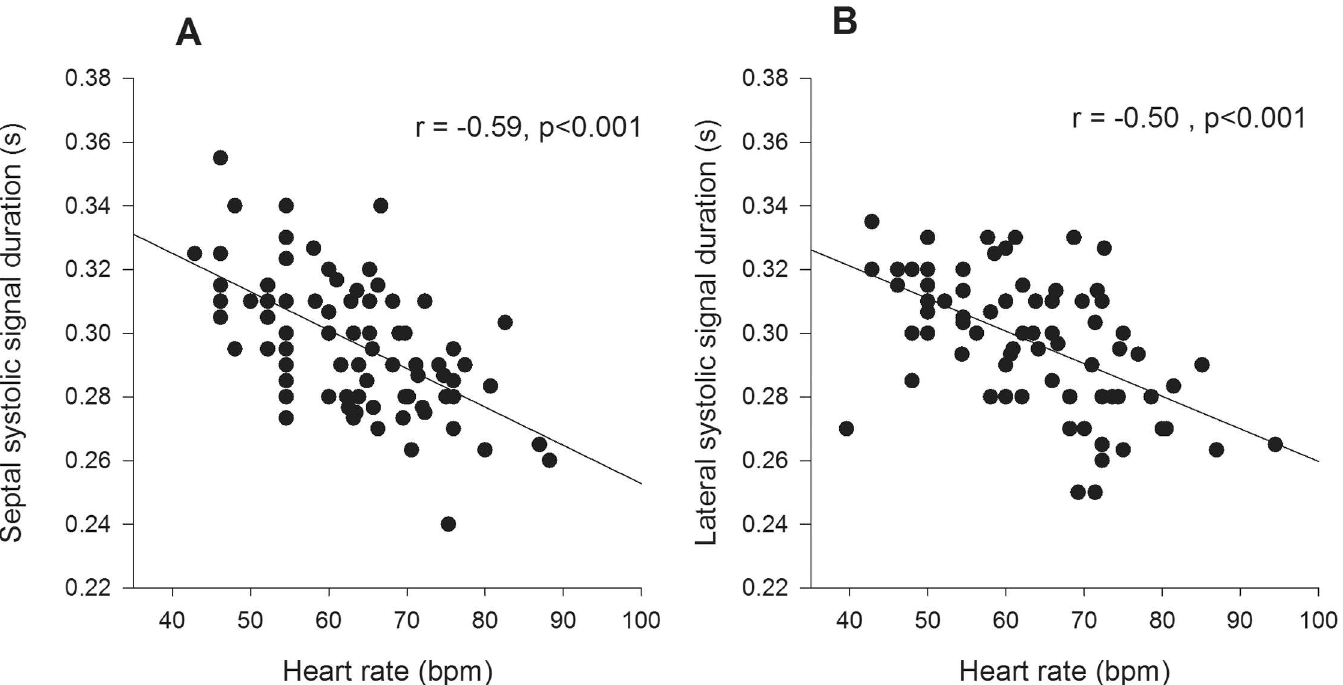
Fig 2. Scatter plots of heart rate v septal systolic signal duration(A) and heart rate v lateral systolic signal duration(B) in Group